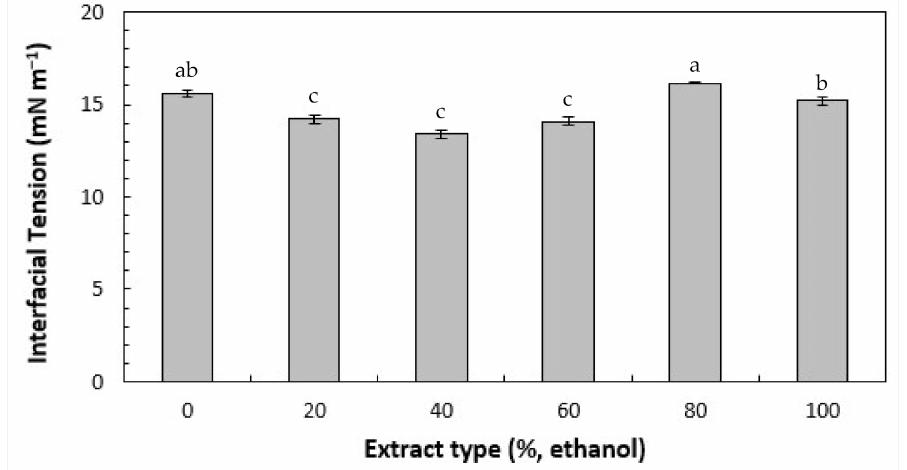
Figure 2. Interfacial tension of aqueous phases containing crude OOC extracts (1%, w/w ). The interfacial tension between soybean oil and Milli-Q water was approximately 26 mN m − 1 . The shared letter(s) indicate(s) no significant difference ( p <